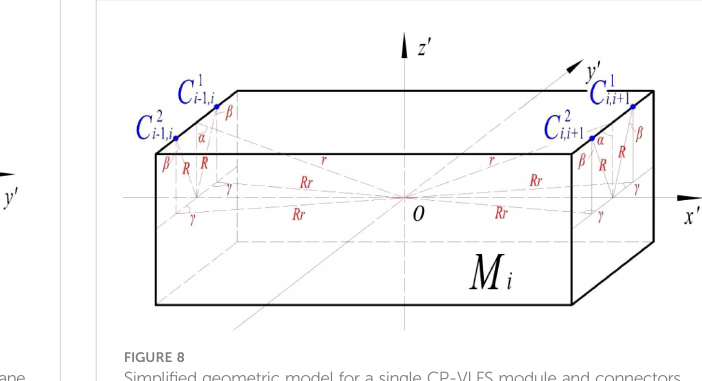
FIGURE 7 LCS and physical dimensions of a single CP-VLFS module in the oy ’ z ’ plane.